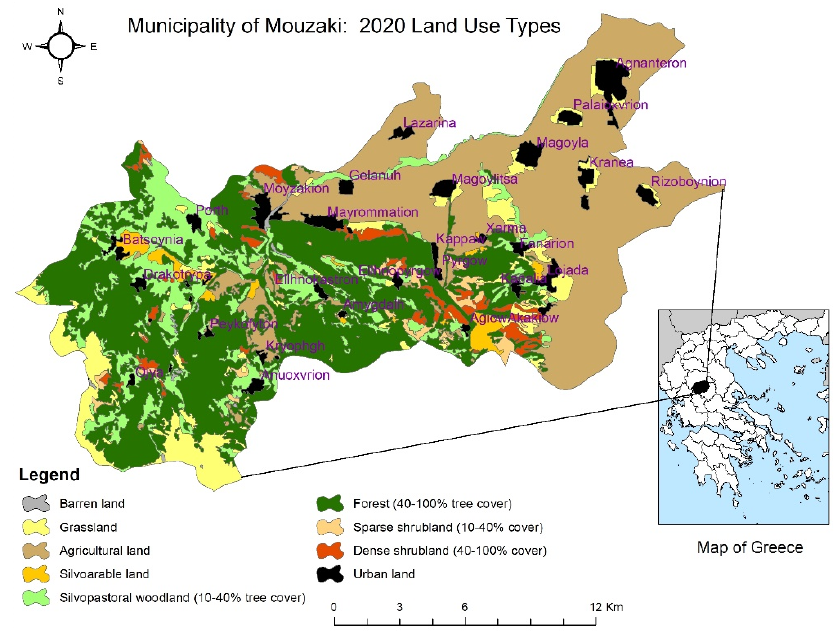
Figure 1. Land use map of Municipality of Mouzaki, Thessaly, Greece for 2020.